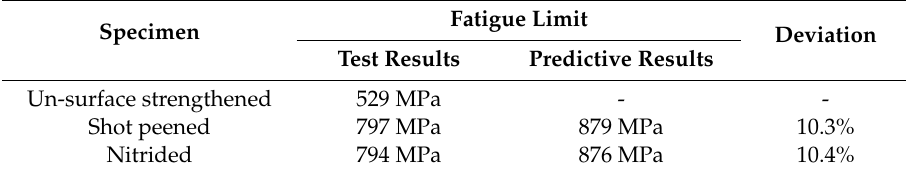
Table 1. Fatigue limit of predictive and test results under different surface treatments.